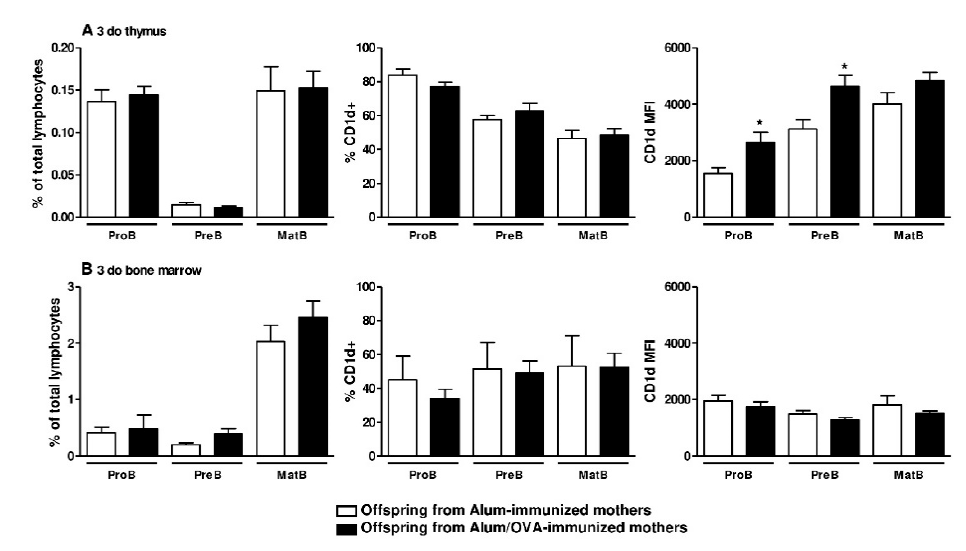
Figure 2. Identification of B cell precursors and CD1d expression evaluation in offspring bone marrow and thymic samples. Female mice were immunized with Alum or Alum/OVA, boosted 10 and 20 days later with saline or OVA, respectively, and mated at day 21. Offspring thymocytes and bone marrow from both groups were evaluated at 3 d.o. ( n = 12–13 pups in each group; pups were delivered from four mothers in each group). Gating strategy to identify thymic and bone marrow B cell maturation stages and CD1d expression are demonstrated in Figure S4. ( A ) Total thymic B cell maturation stages (ProB, PreB, and MatB) are expressed as the percentage of cells gated as lymphocytes, the CD1d frequency, and intensity of expression at each maturation stage were evaluated. ( B ) Total bone marrow B cell maturation stages (ProB, PreB, and MatB) are expressed as the percentage of cells gated as lymphocytes, the CD1d frequency and intensity of expression at each maturation stage were evaluated. Data are presented as the mean ± SEM. * p ≤ 0.05 compared with the Alum-immunized groups using Mann–Whitney U test.